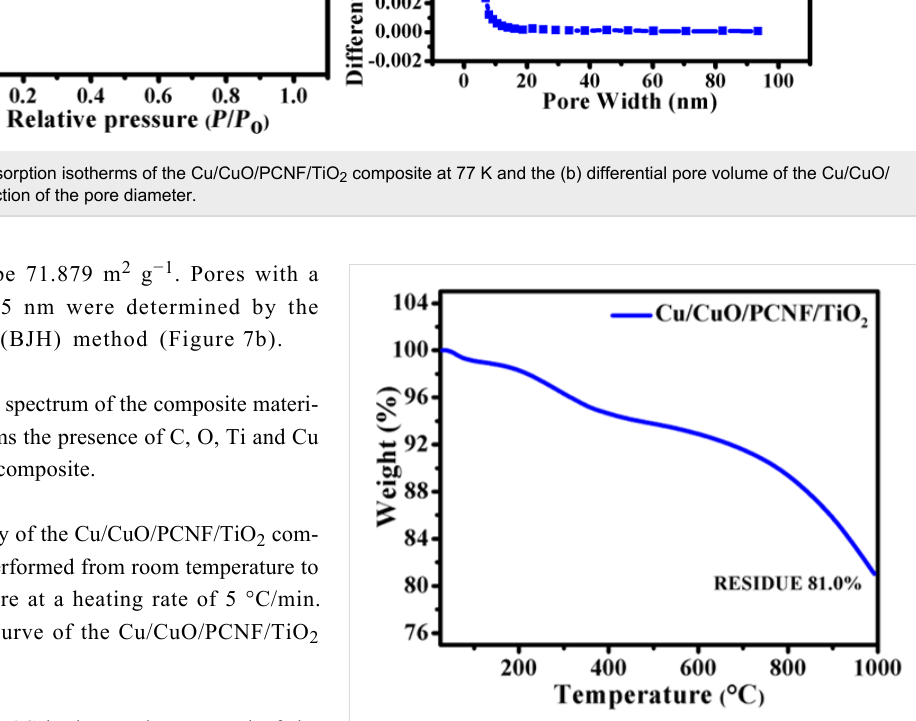
Figure 9: Thermogravimetric curve of the Cu/CuO/PCNF/TiO 2 com-